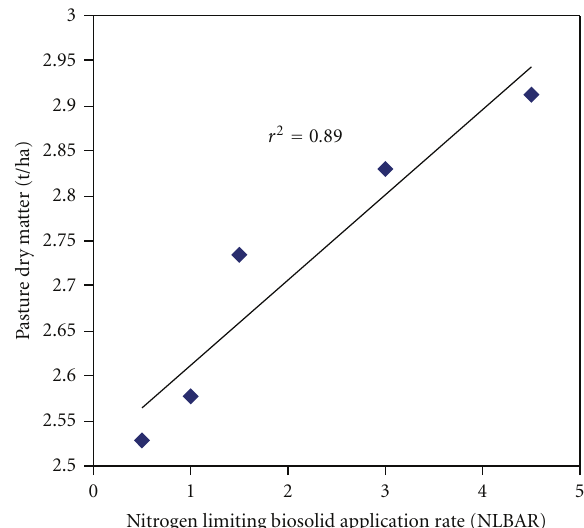
Figure 3: Mean pasture dry matter production versus biosolid application rate at Pakenham site from 2004 to 2006.